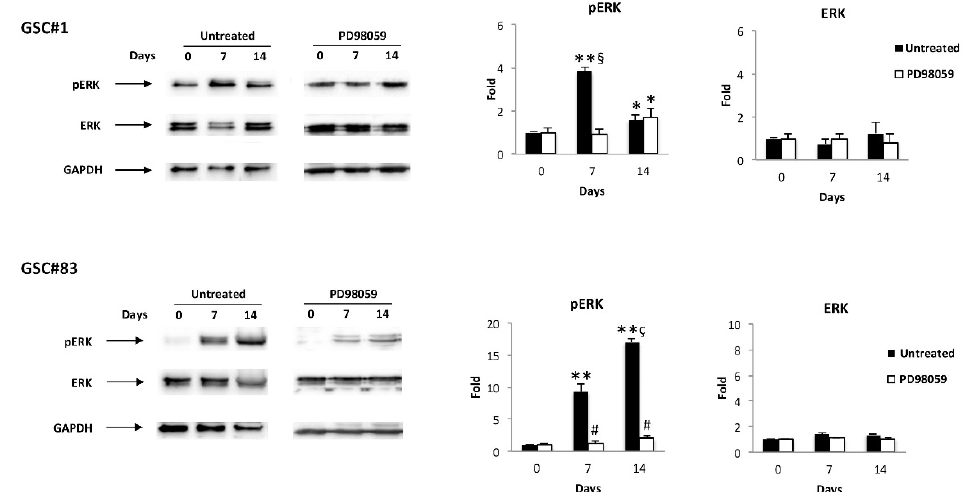
Figure 3. ERK modulation during GSC differentiation: western blot analysis of pERK and ERK protein levels in GSC#1 and GSC#83 untreated or treated with PD98059 for up to 14 day of differentiation. Blots are representative of one of three separate experiments. ERK densitometry values were normalized to GAPDH used as loading control. The pERK levels were determined with respect to ERK levels. * p < 0.05 vs. undifferentiated cells (time 0); ** p < 0.001 vs. undifferentiated cells (time 0); # p < 0.001 vs. untreated cells; ç p < 0.001 vs. 7 days of differentiation; § p < 0.001 vs. 14 days of differentiation.